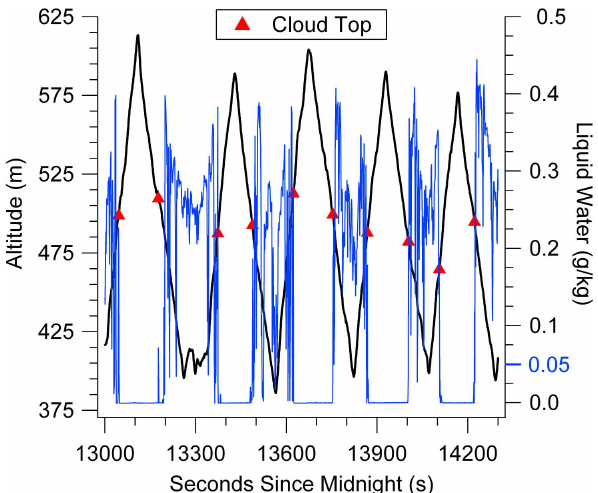
Fig. 1. Sample segment of a research flight during which the aircraft is performing sawtooth maneuvers across the stratocumulus cloud top. Black lines denote altitude and blue lines denote liquid water content. The red triangles mark the time and altitude of cloud top of 0.05g kg − 1 for each ascent or